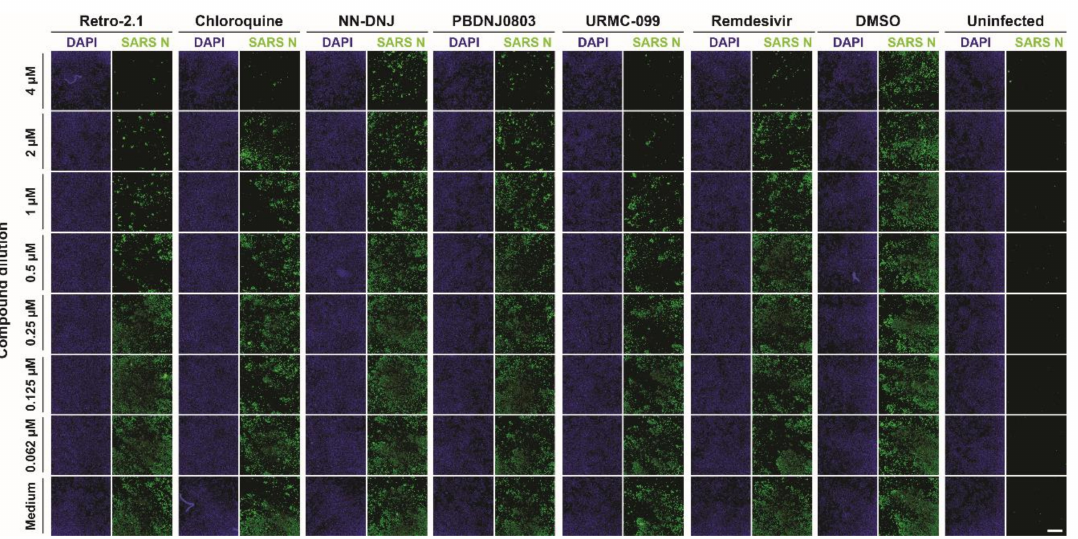
Figure 2. Assessment of the antiviral e ffi ciency by immunofluorescence. To determine the e ffi ciency of inhibition of each specific compound from the survival screen, a two-fold dilution series ranging from 4 µ M to 0.062 µ M was prepared following infection with SARS-CoV-2. Vero E6 cells were pretreated with the compound 2 h prior to infection with SARS-CoV-2 (MOI of 0.01) at 37 ◦ C in a humidified incubator with 5% CO 2 . Cells were fixed 24 h post-infection, followed by immunostaining with the cross-reactive SARS-CoV nucleoprotein antigen (SARS N) and 4 (cid:48) ,6-diamidino-2-phenylindole (DAPI). Remdesivir was included as a positive control. The images are representative of the results of three individual experiments. Scale bar: 1000 µ